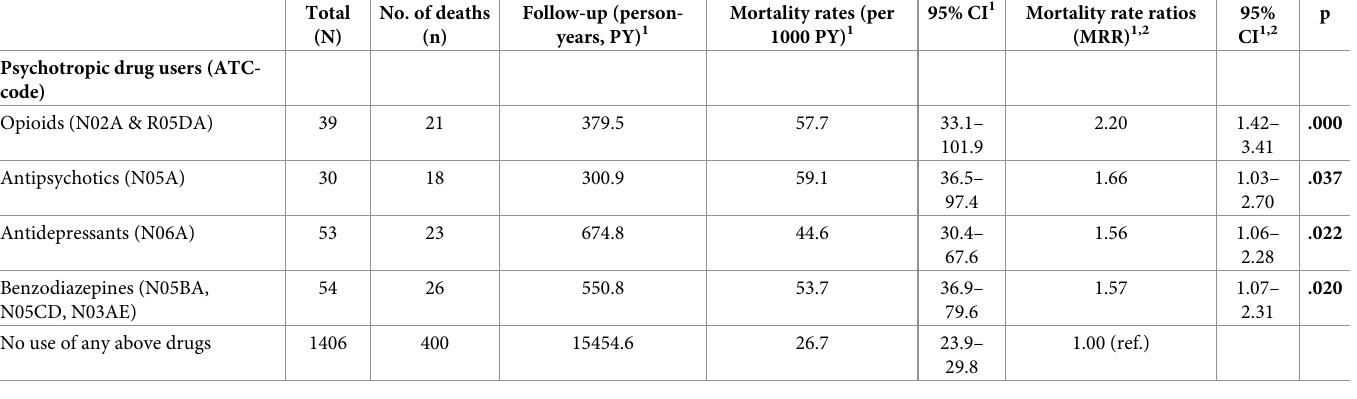
Table 2. Mortality rates and mortality rate ratios by the use of psychotropic drugs. GNHIES98 mortality follow-up study. Total